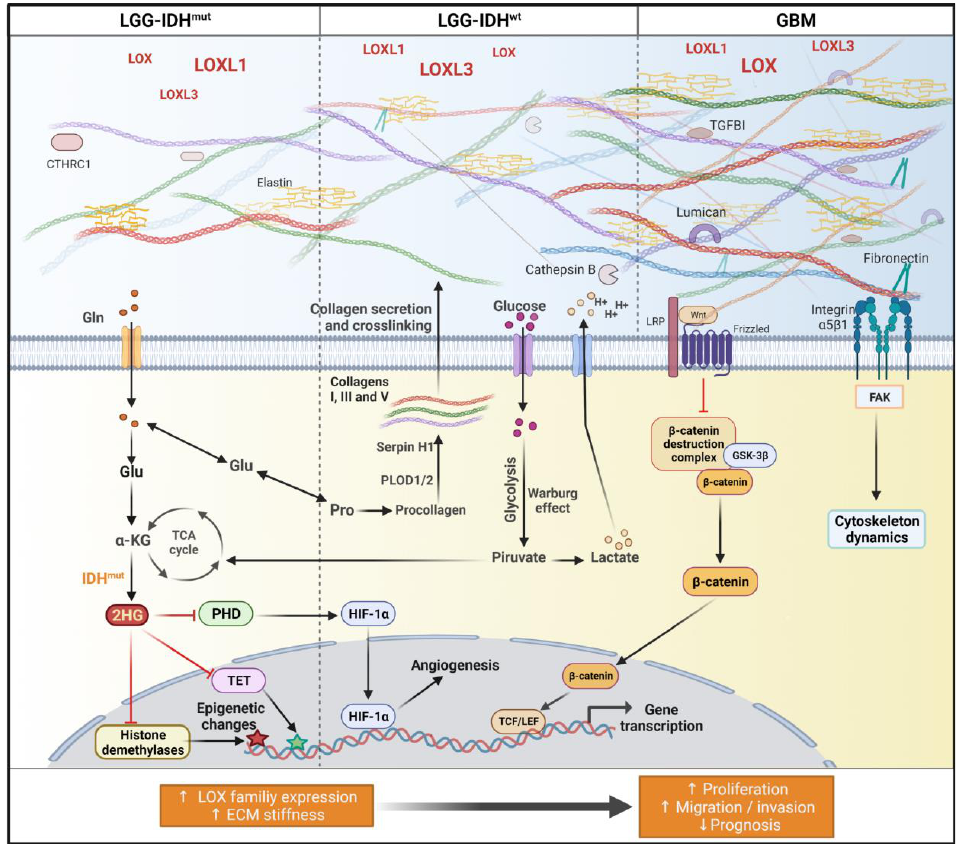
Figure 7. Schematic diagram representing LOX family influence in extracellular matrix composition of astrocytomas. Malignancy and aggressiveness increase from LGG-IDH mut , LGG-IDH wt , and